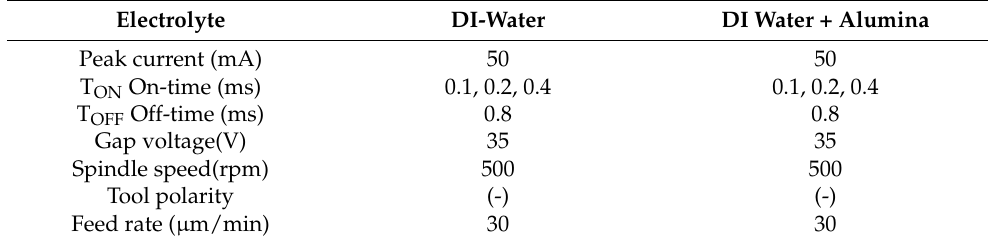
Table 3. Operational conditions for DI-ECM and hybrid ECM with alumina powder. Electrolyte